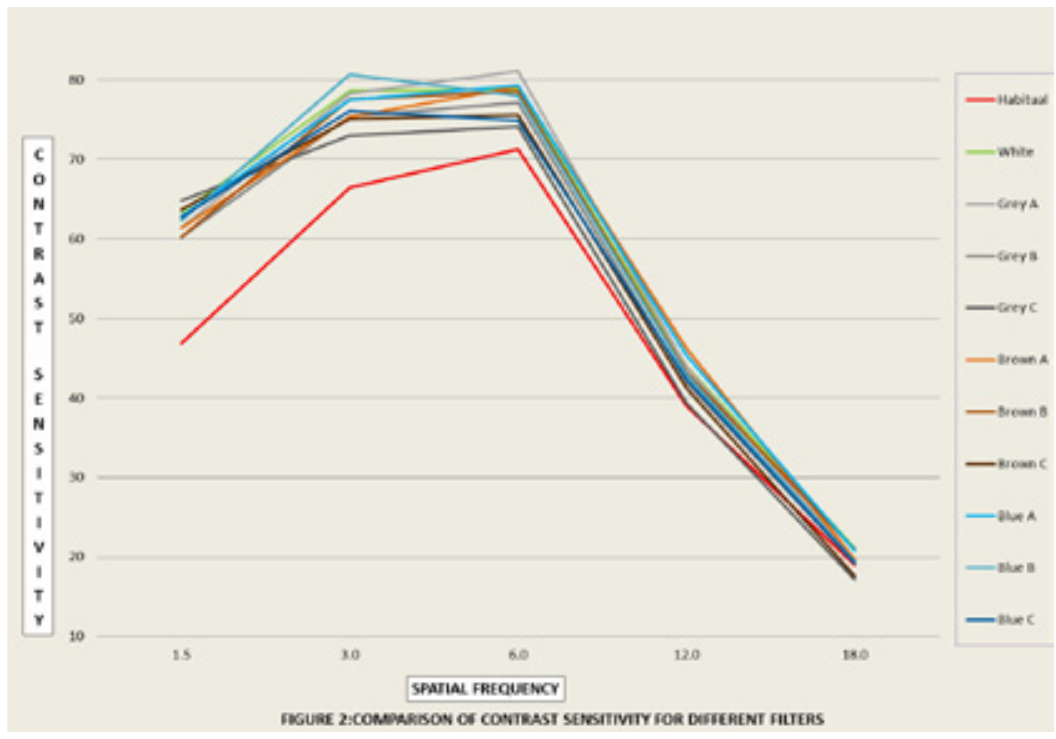
Figure 1 : Comparison of the mean values of contrast sensitivity between different filters and their grades at varying spatial frequencies to the habitual